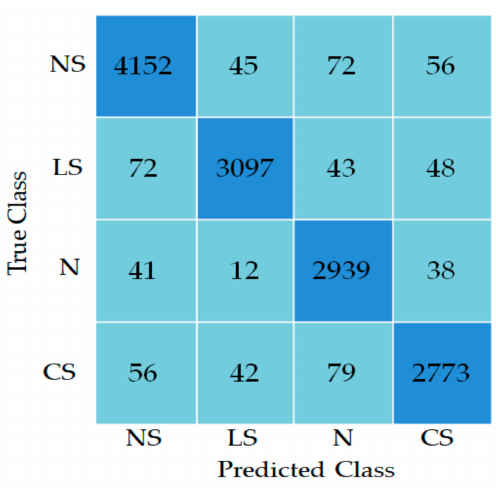
Figure 11. Confusion matrix. NS, normal sound; LS, low sound; N, noise; CS, collision